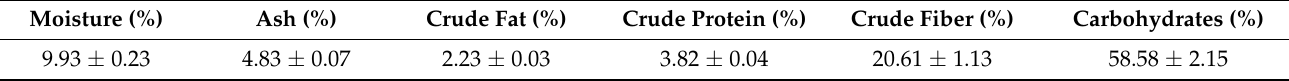
Table 1. Composition of Lemongrass Leaves